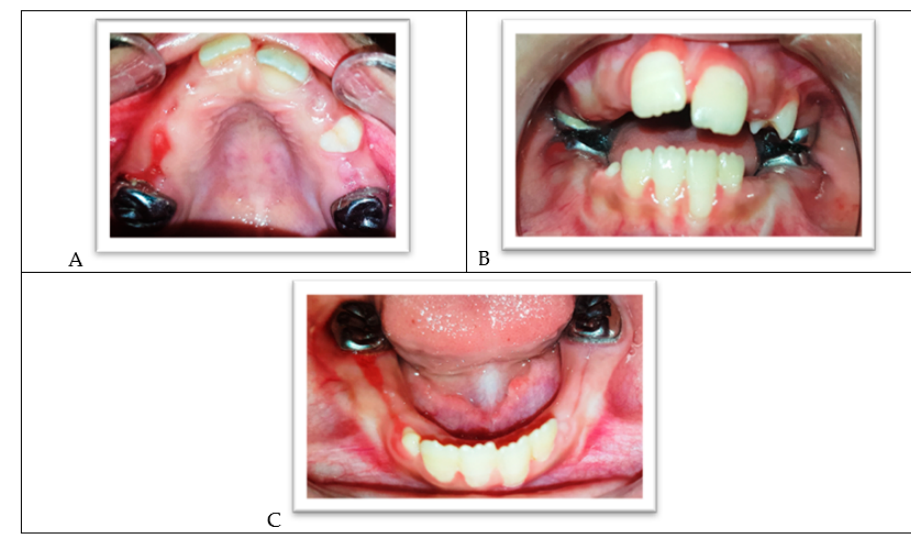
Figure 8. 1 month after treatment. ( A ) The upper arch. ( B ) Anterior view in occlusion. ( C ) The lower arch.